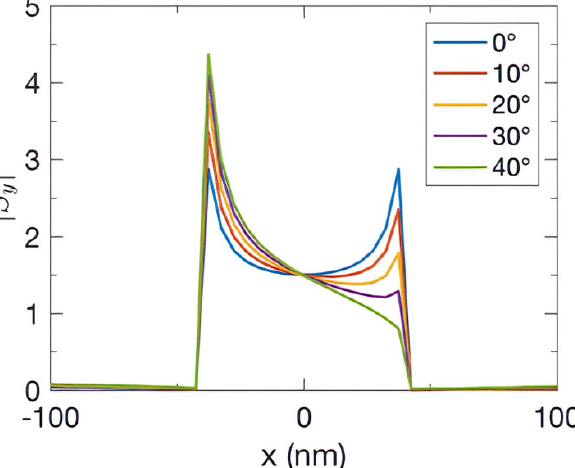
Figure 4. The magnitude of normalized Poynting vector of the y component | Sy | at the PEC interface, y = 0, at various incident angles, when the magnetic field at the left corner reaches its positive maximum.